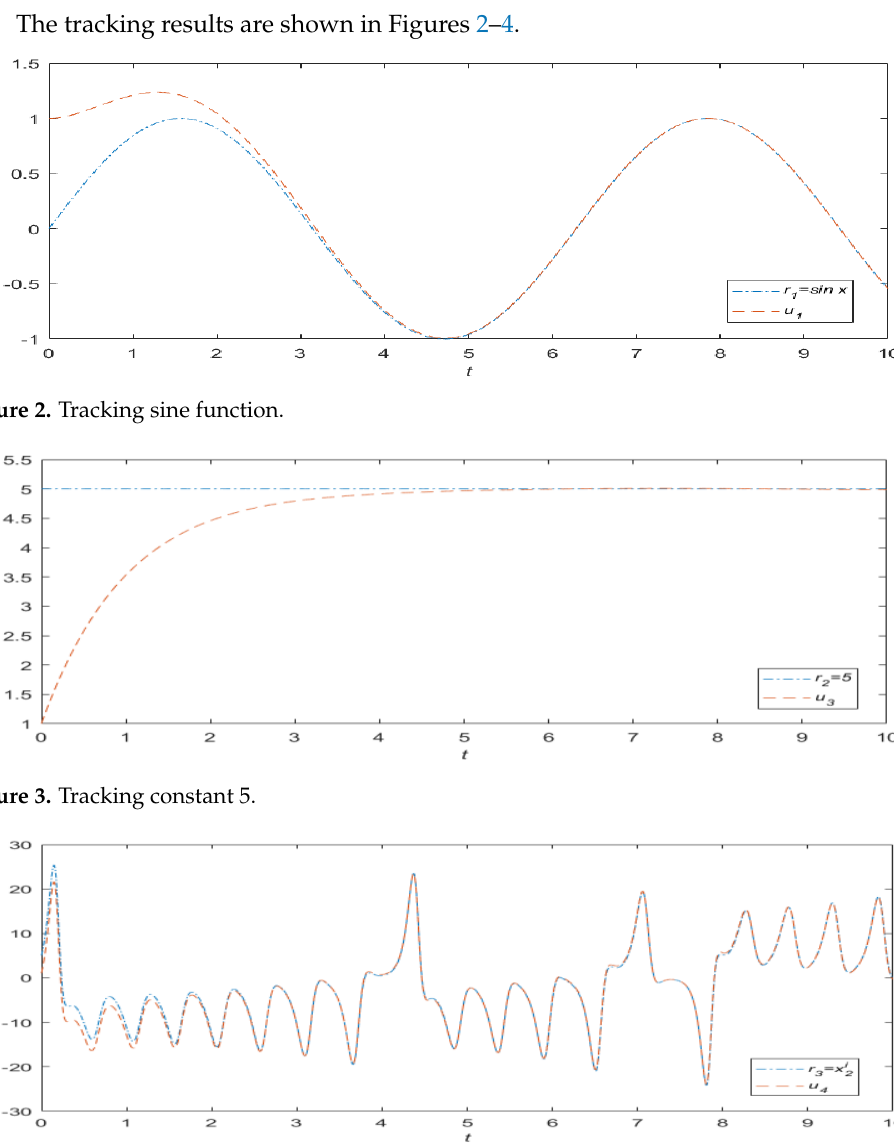
Figure 4. Tracking the fourth dimension of the complex Lorenz chaotic system.